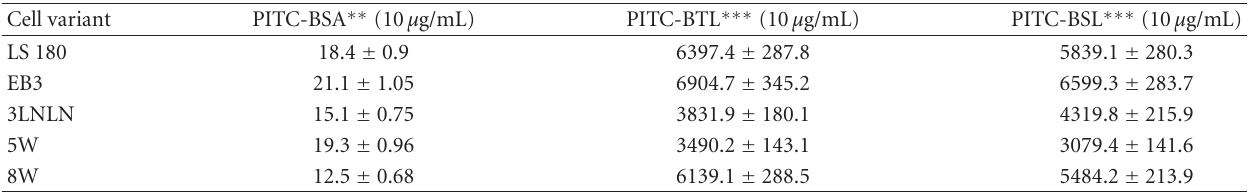
Table 1: Interaction of PITC-lectin complexes (expressed in fluorescence units, FU ∗ ) with human colon cancer cells. Cell